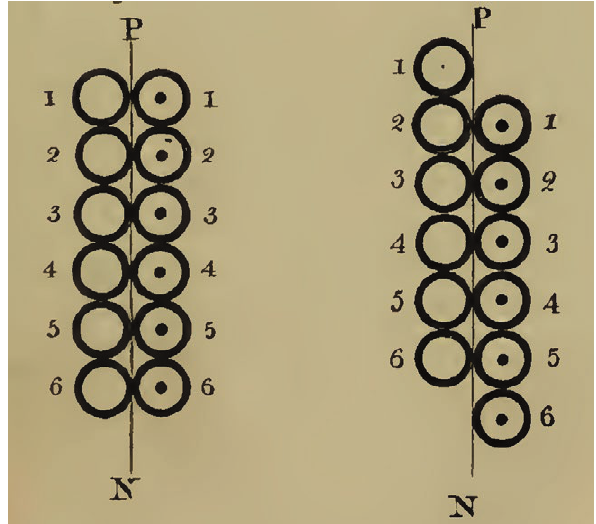
Figure 7. Illustration of Davy´s theory of the electrophoretic migra- tion of the oppositely charged particles of a neutral salt during elec- trolysis. P, N: positive and negative poles. ⊙ , ○ : positiv and negativ particles of the neutral salt ○⊙ , which forms a conducting chain in the solution. Left and right pictures: arrangement prior and after closing the circuit. See the main text for details and footnote 53 for author’s comment. Taken from ref. [80] . Nearly the same scheme is depicted by Berzelius to illustrate his similar theory in ref. [81] , p.